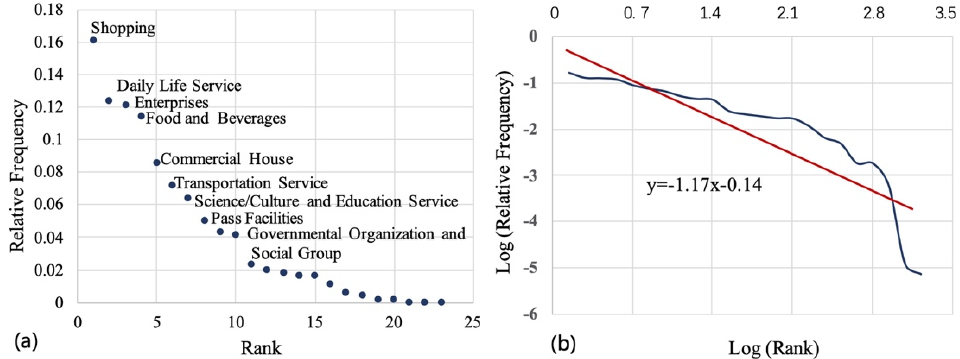
Figure 3. Rank-frequency plot for POIs. ( a ) Relative frequency plot. ( b ) Relative frequency log plot.